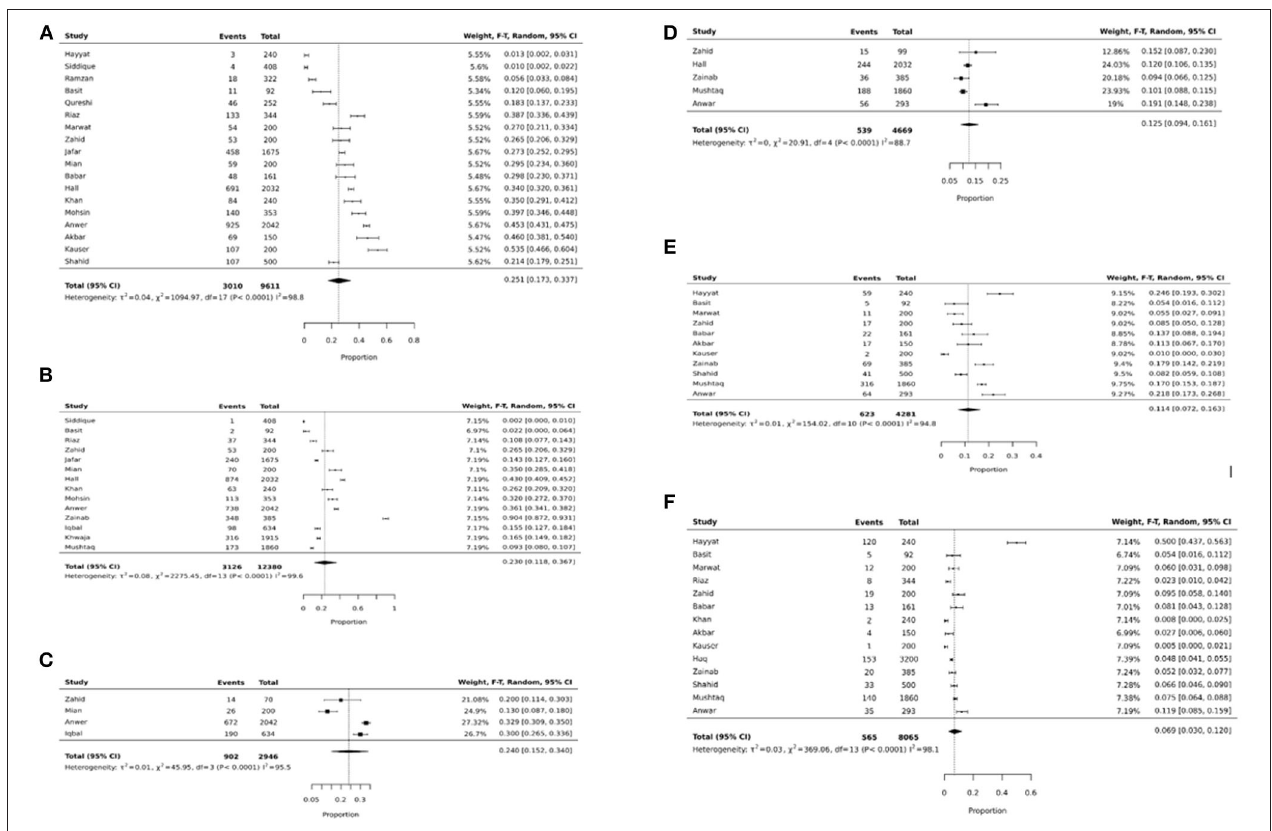
FIGURE 2 | (A) Underweight pooled prevalence in 5–15 years. (B) Stunting pooled prevalence in 5–15 years. (C) Wasting pooled prevalence in 5–15 years. (D) Thinness pooled prevalence in 5–15 years. (E) Overweight pooled prevalence in 5–15 years. (F) Obese pooled prevalence in 5–15 years.